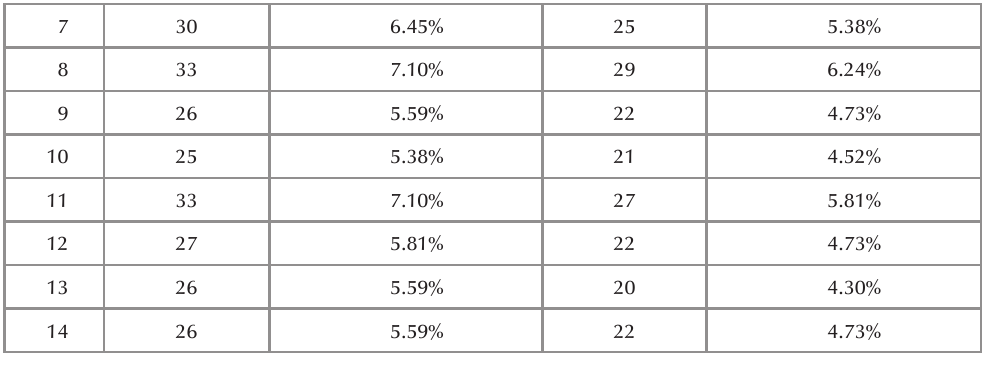
Graphical comparison of VaR forecast accuracy for both LVaR